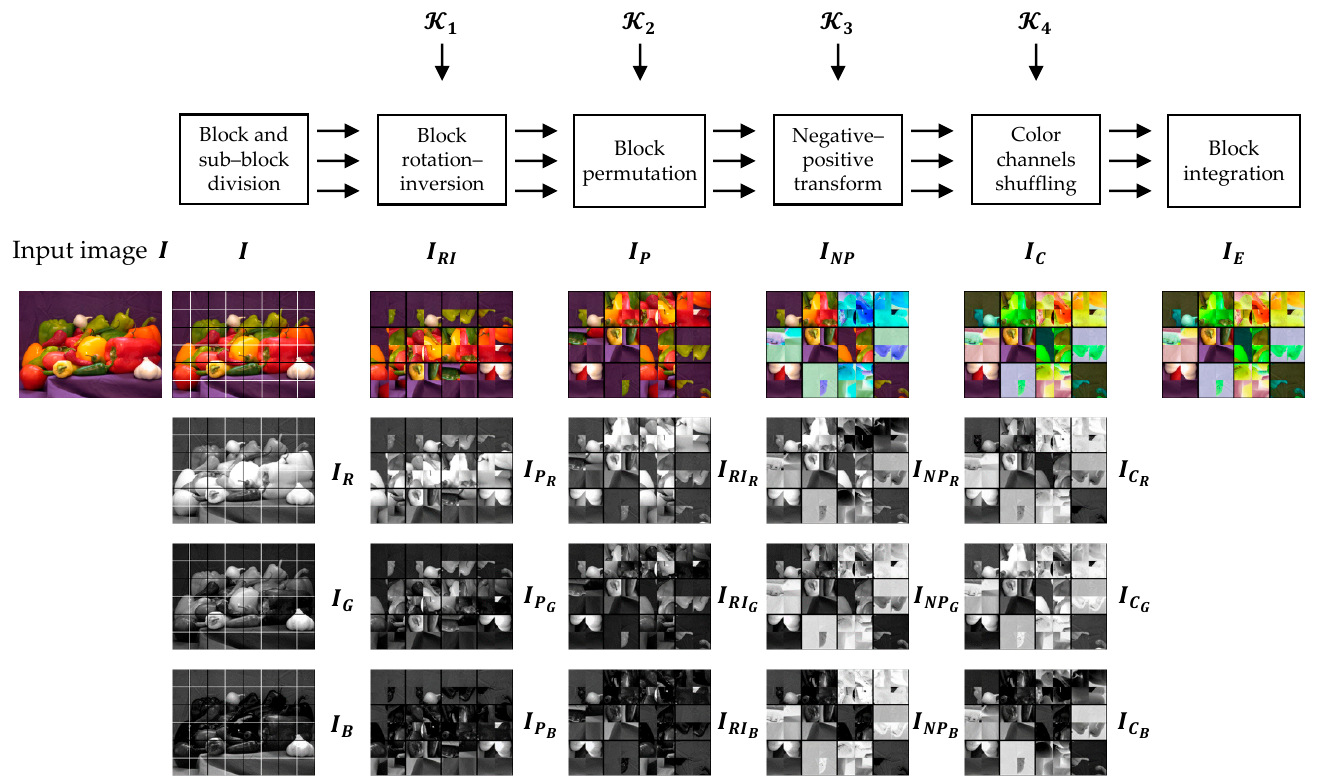
Figure 6. The encryption algorithm steps of an IIB–CPE scheme. The black line shows block division, whereas the white line shows sub-block division. For visual analysis, the effect of each transformation function on the image is shown across each color channel. The keys 𝓚 𝒊 , 𝑖 = 1, … , 4 is a set of keys used in each step to process the color channels. The local contents in each block are scrambled because of the sub-block processing.